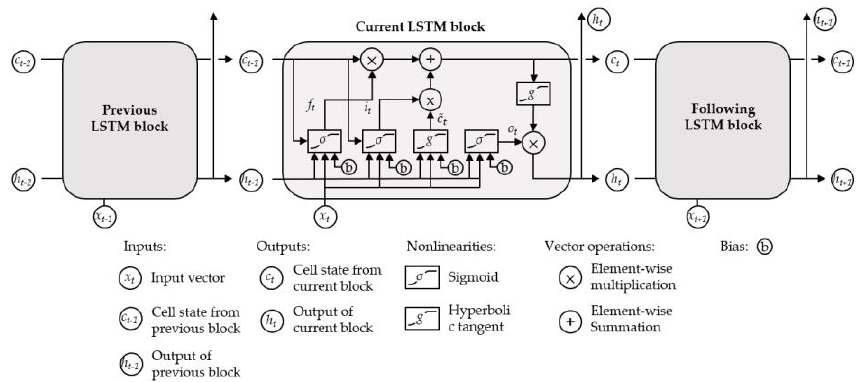
Figure 3. The architecture of the LSTM.